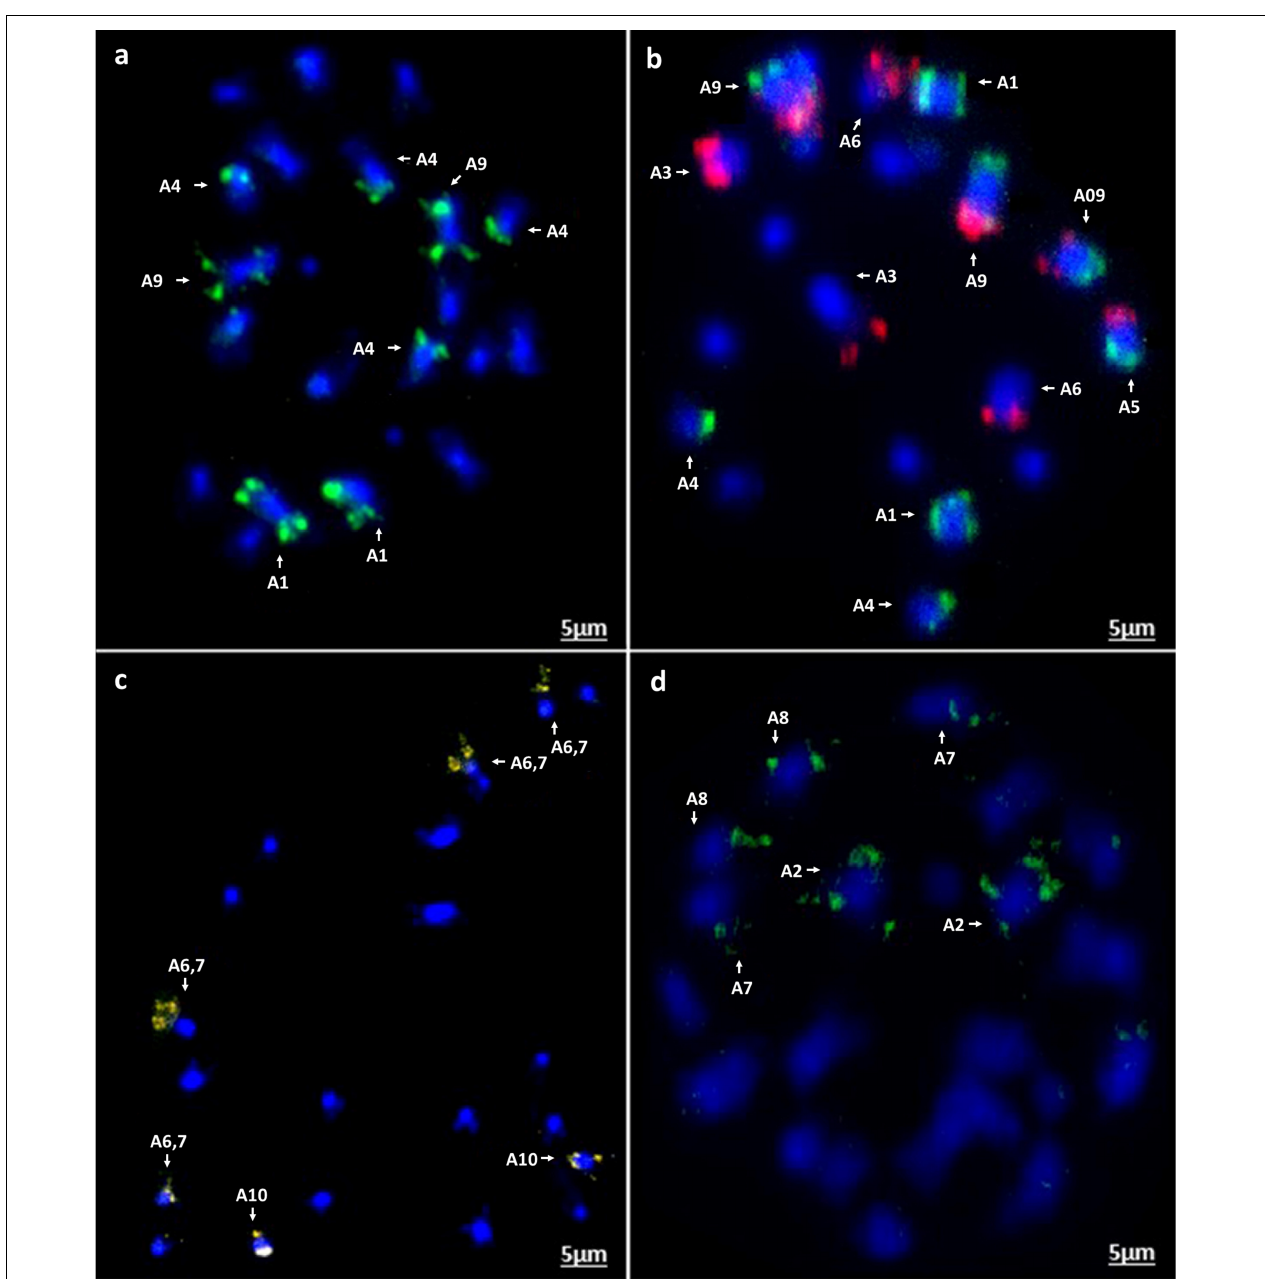
FIGURE 7 | In situ hybridization on mitotic chromosome spreads of B. rapa cv. Chiffu-401 using four oligonucleotide libraries. Chromosomes are stained blue with DAPI and oligonucleotide probe hybridization sites are seen in the other colors (a) green-Atto488, (b) red-Atto550 and green-Atto488 as dual color in situ , (c) yellow-Atto594, and (d) green-Cy5. Scale bars = 5 µ